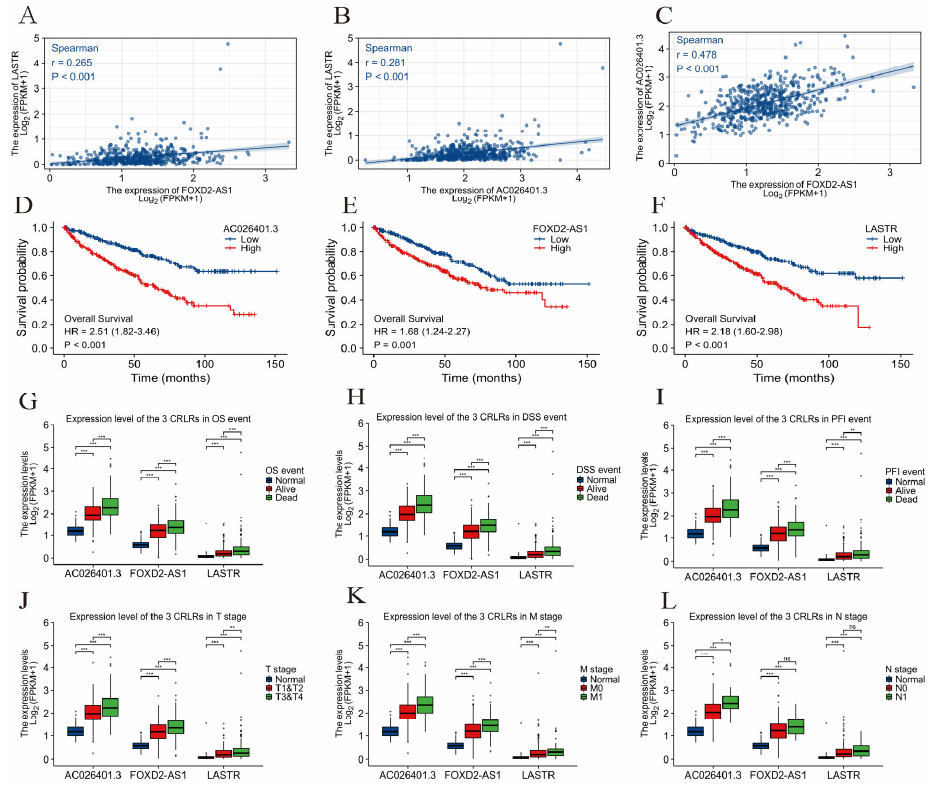
Figure 3. The clinical correlations analysis of the three CRLRs. ( A ) The molecular correlation of LASTR and FOXD2-AS1 in TCGA-KIRC. ( B ) The molecular correlation of LASTR and AC026401.3 in TCGA-KIRC. ( C ) The molecular correlation of FOXD2-AS1 and AC026401.3 in TCGA-KIRC. ( D ) K‒M curves of AC026401.3 between the different expression level groups in TCGA-KIRC. ( E ) K‒M curves of FOXD2-AS1 between the different expression level groups in TCGA-KIRC. ( F ) K‒M curves of LASTR between the different expression level groups in TCGA-KIRC. ( G ) Expression level of three CRLRs in OS event. ( H ) Expression level of three CRLRs in DSS event. ( I ) Expression level of three CRLRs in PFI event. ( J ) Expression level of three CRLRs in T stage. ( K ) Expression level of three CRLRs in M stage. ( L ) Expression level of three CRLRs in N stage. (* p < 0.05, ** p < 0.01, *** p < 0.001).